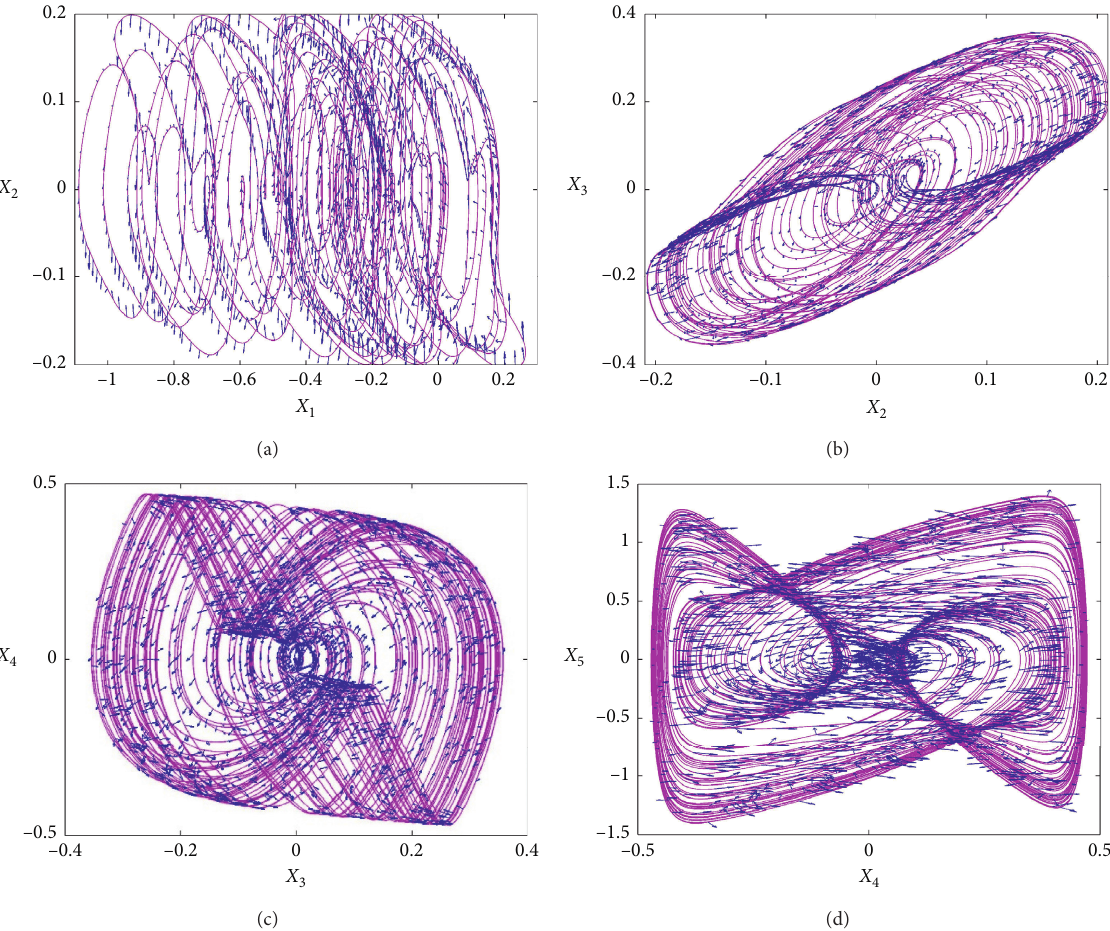
Figure 5: The zero Lyapunov vectors (LE3): (a) first and second components of zero Lyapunov vectors (LE3) in x and third components of zero Lyapunov vectors (LE3) in x x − x plane; (d) fourth and fifth components of zero Lyapunov vectors (LE3) in x 3 4